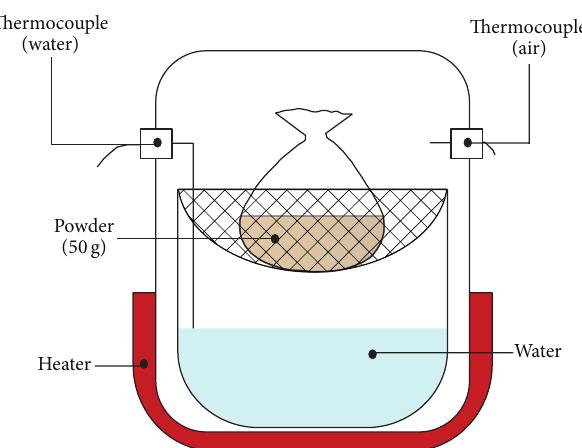
Figure 1: Particle size distribution of bamboo powder.